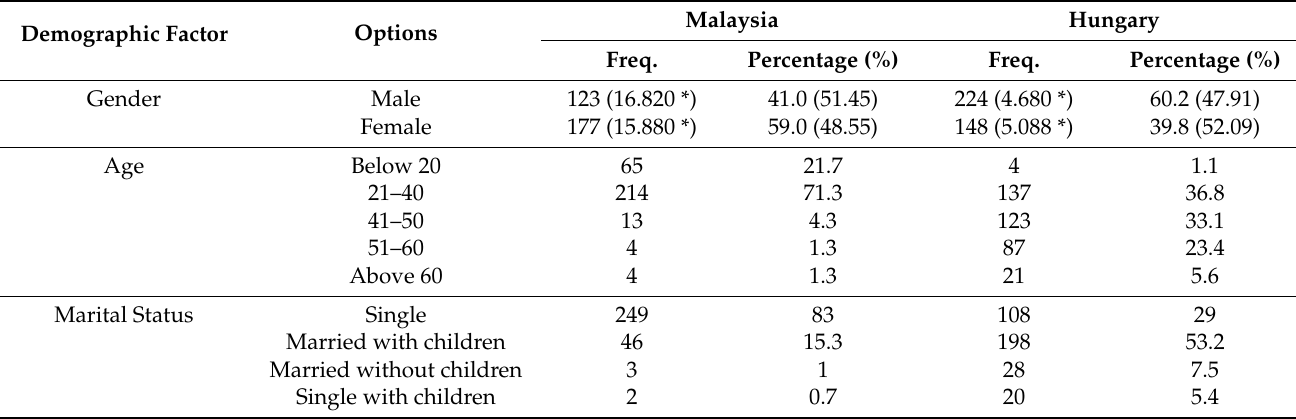
Table 1. Respondents’ demographic information.